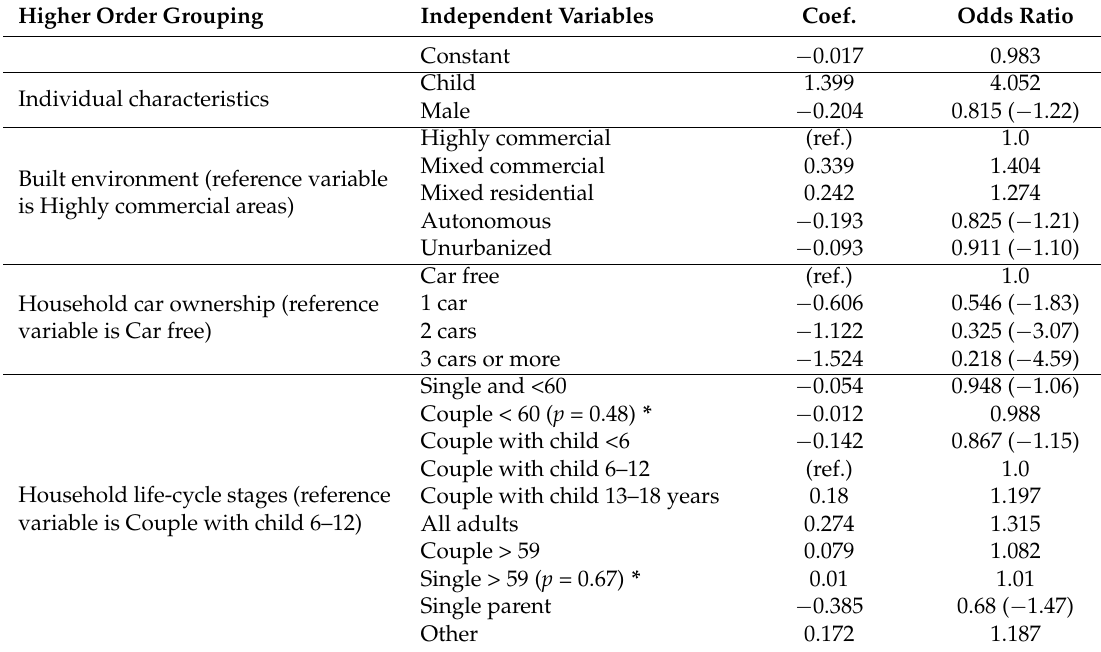
Table 5. Binary logistic regression results for an individual achieving an accumulated 30 min of physical activity through active travel ( n =